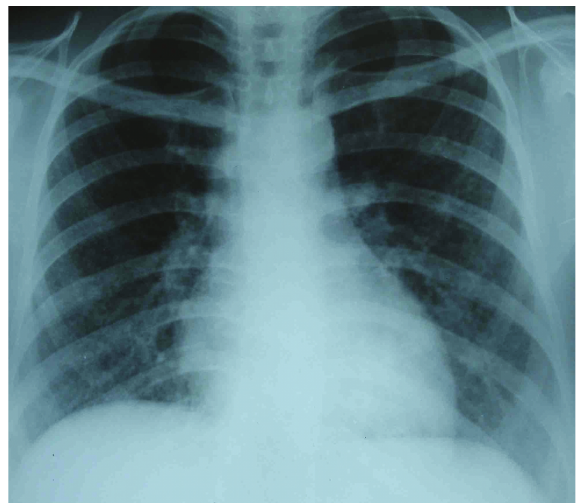
Figure 1: Chest radiograph showing bilateral di ff use miliary nod- ular lesions.